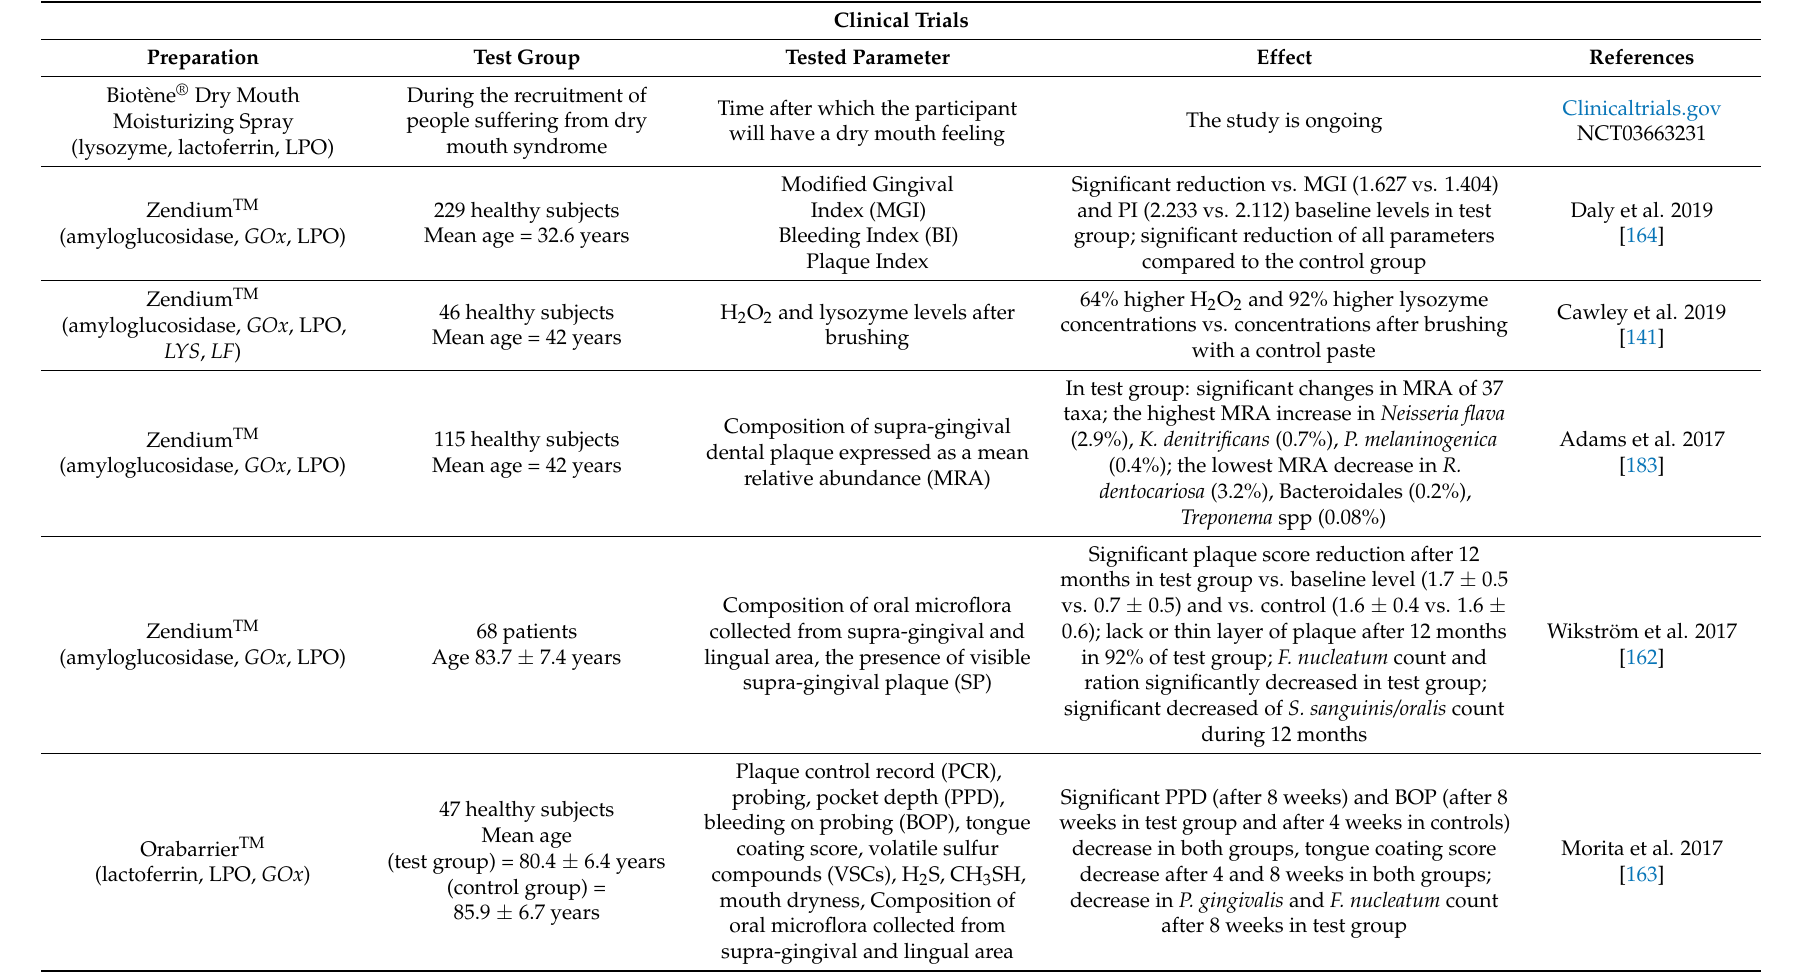
Table 2. Summary of clinical trials and in vitro tests using